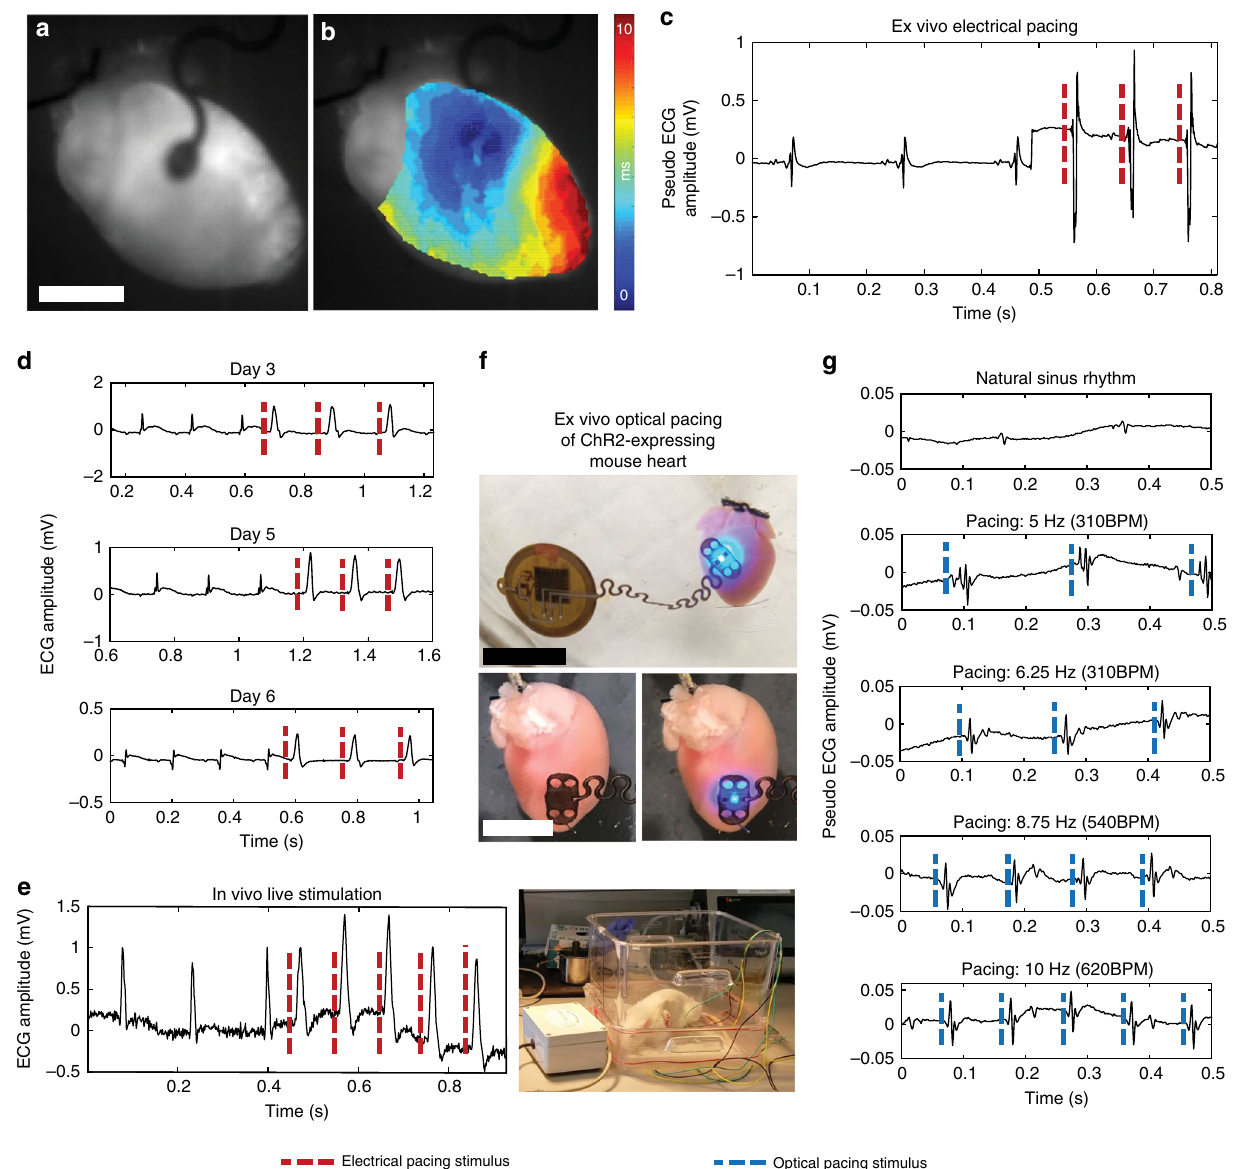
Fig. 5 Electrical and optogenetic pacing capabilities. a Mouse hearts were electrically stimulated by the device ex vivo (scale bar 0.5 cm). b The time course of pacing activation was tracked using the membrane potential to show anisotropic conduction by optical mapping. c Far- fi eld ECG pacing demonstrates capture of the heart during ex vivo pacing. d Chronic in vivo pacing of rat hearts was achieved with implanted pacemakers for up to 6 days. e Rat hearts were captured (right) while the animal was freely moving. f Ex vivo ChR2-expressing mouse hearts were optically paced at the anterior epicardial surface of the left ventricle (top) (scale bar 1 mm) in the off (bottom left) and on (bottom right) con fi guration (scale bar 0.5 mm). g Ex vivo ChR2-expressing mouse hearts were able to be captured at 280, 310, 540, and 620